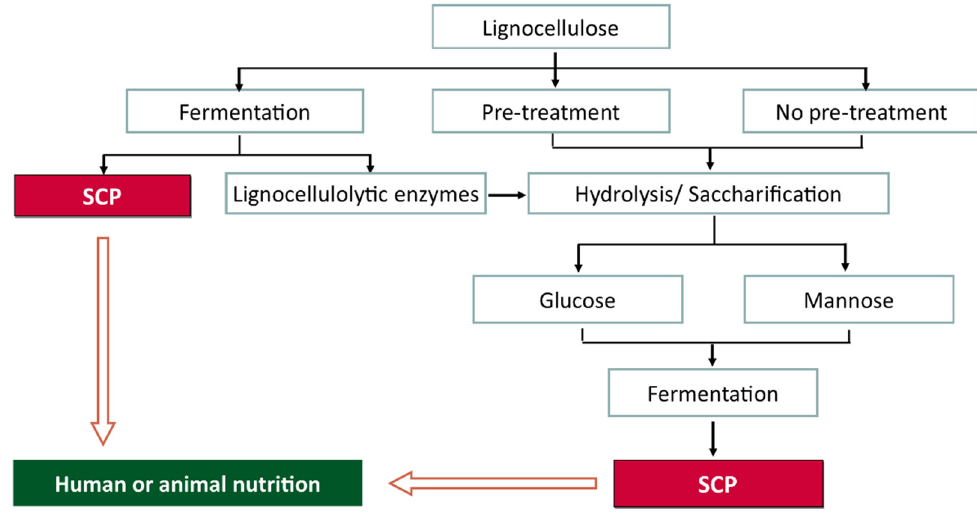
Figure 4. Generalized process stages of lignocellulose bioconversion into SCP; extracted from